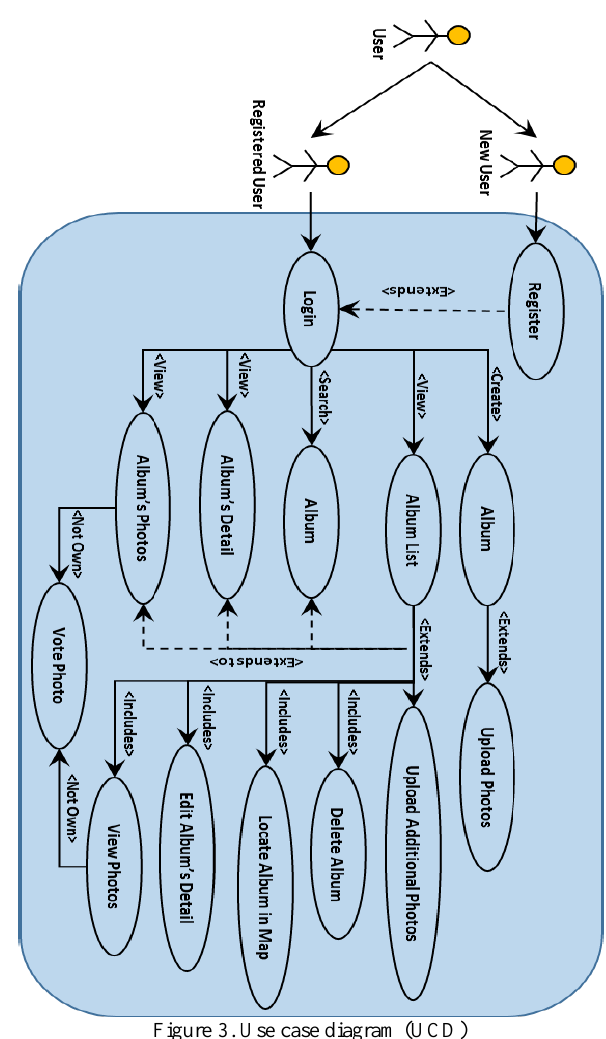
Figure 4. Entity Relationship Diagram